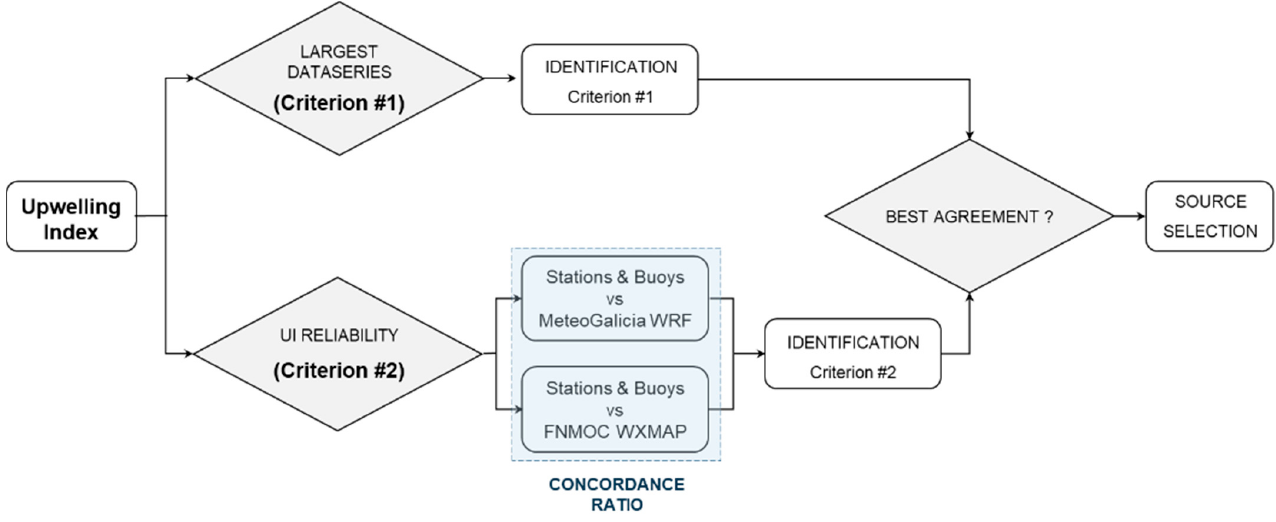
Figure 2. Flowchart on the methodology followed for selecting a data source.